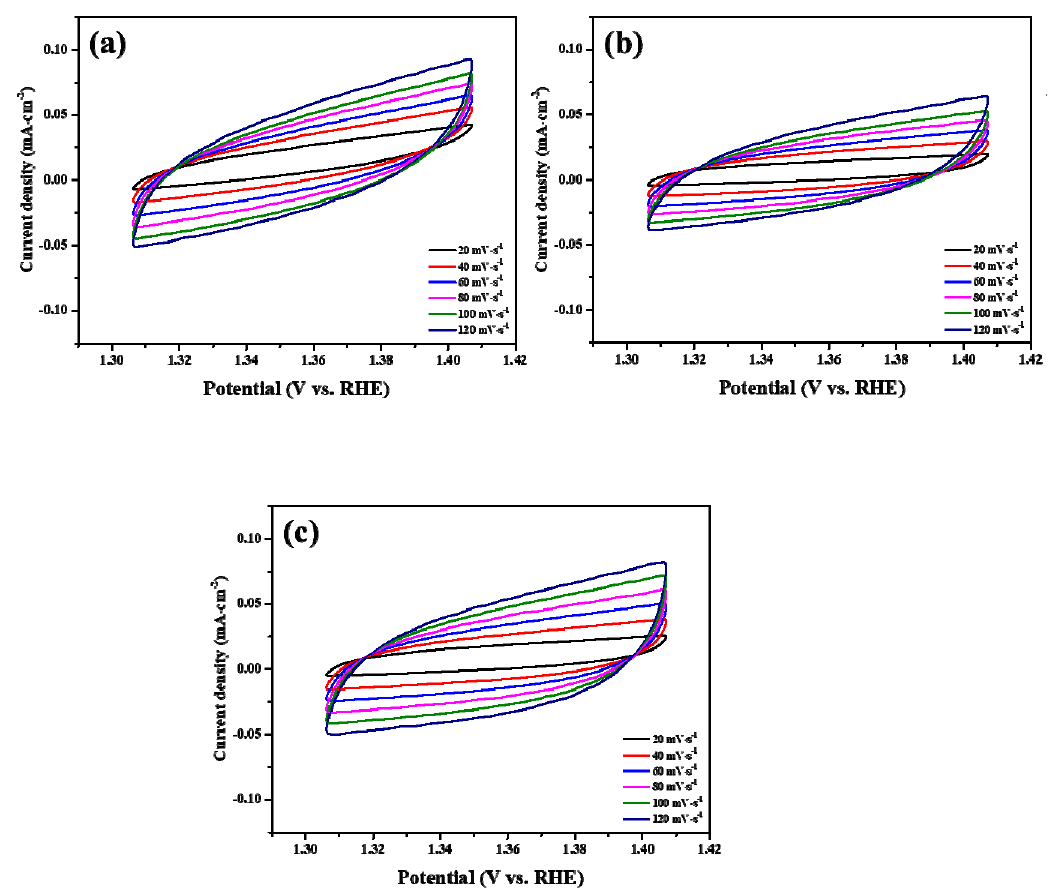
Figure 9. Cyclic voltammetry curves in a capacitive current region at various scan rates (20, 40, 60, 80, 100, and 120 mV · s -1 ) of ( a ) Co 1.2, ( b ) Co 2.4, and ( c ) Co 2.4.